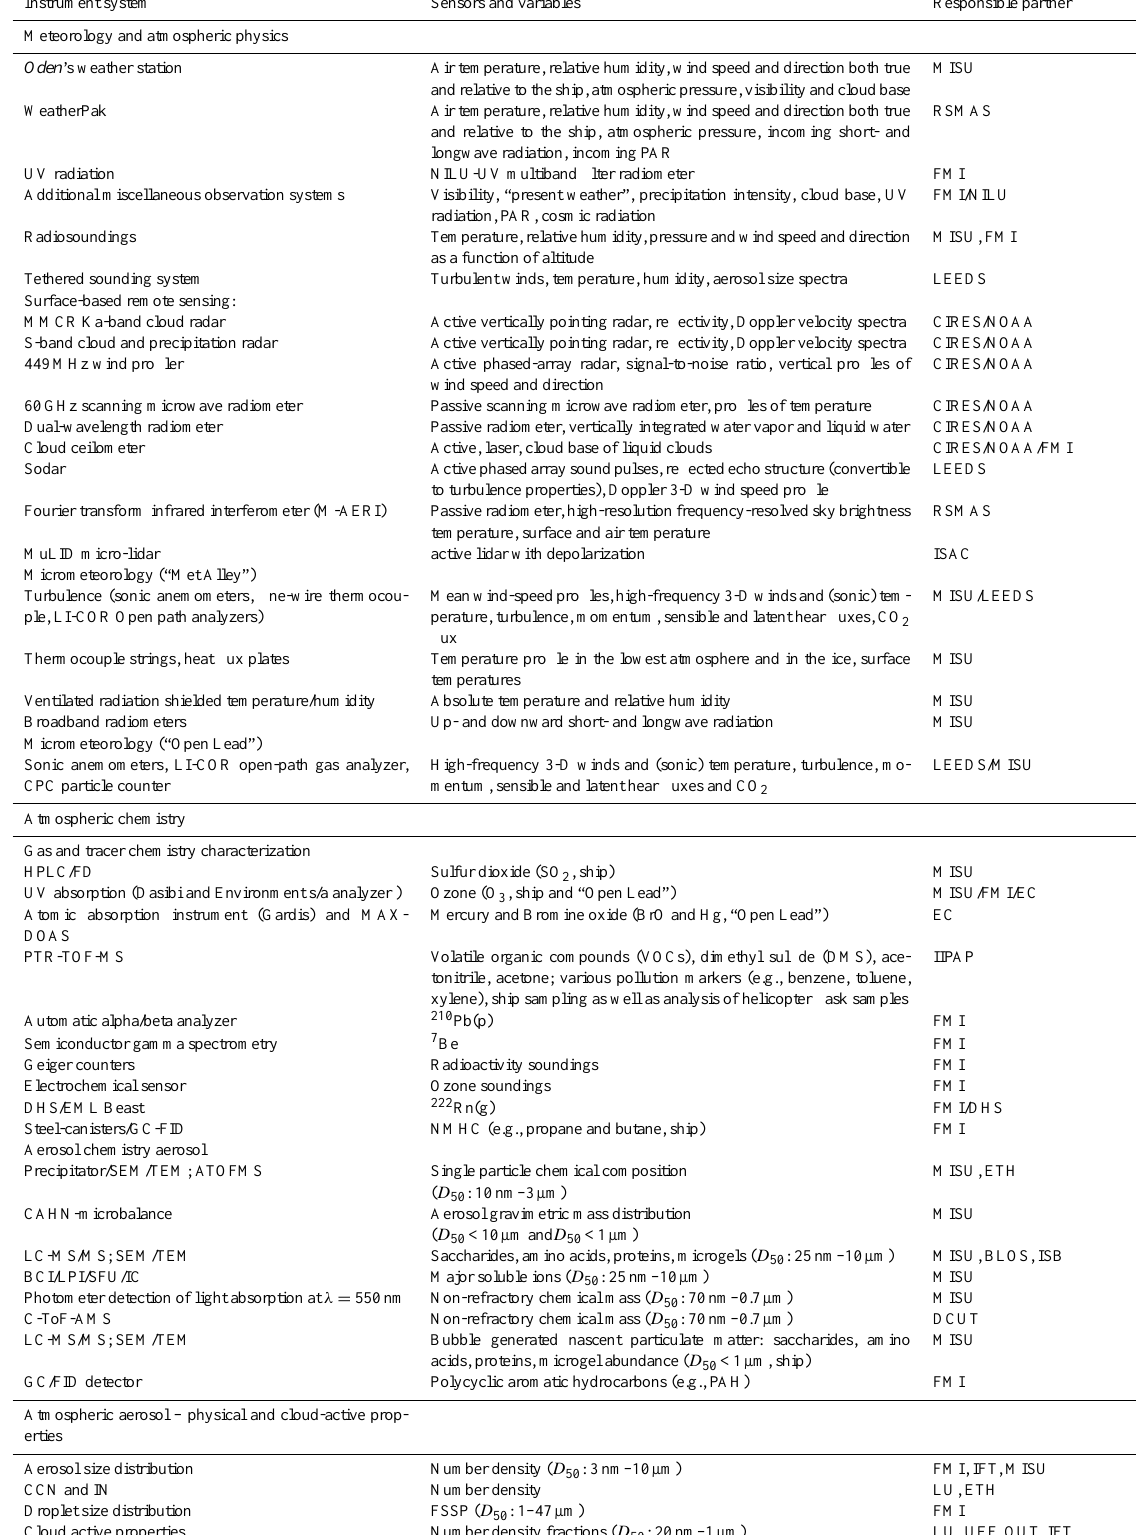
Table 3. Measurement overview; see Table 1 for abbreviations and Table 2 for the participants’